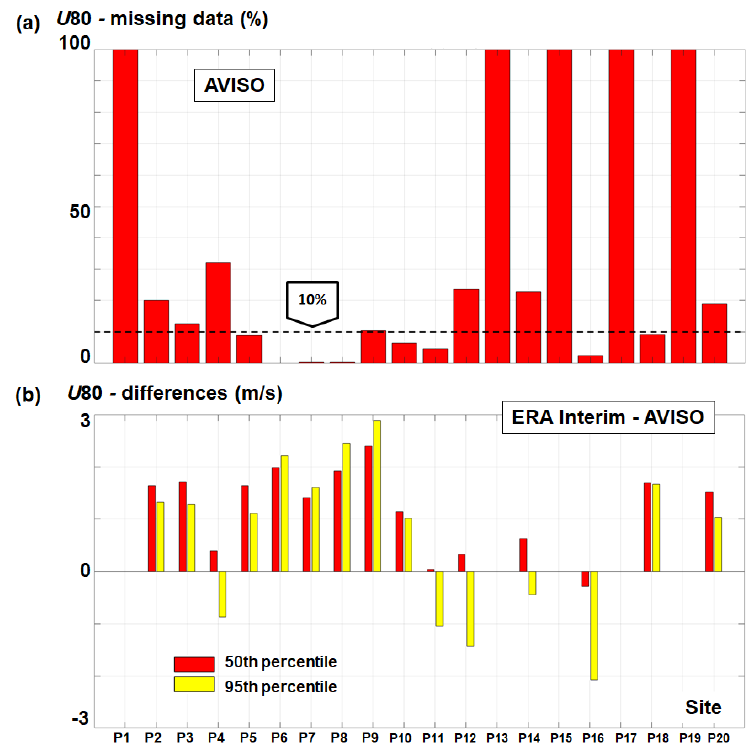
Figure 3. Comparison between the ERA-Interim wind data and the satellite measurements (from AVISO) corresponding to the time interval September 2009–September 2017. Results indicated in terms of: ( a ) missing data reported by AVISO; and ( b ) differences reported between ERA-Interim and AVISO data, considering the 50th an 95th percentiles, respectively. Energies 2018 , 11 , x FOR PEER REVIEW